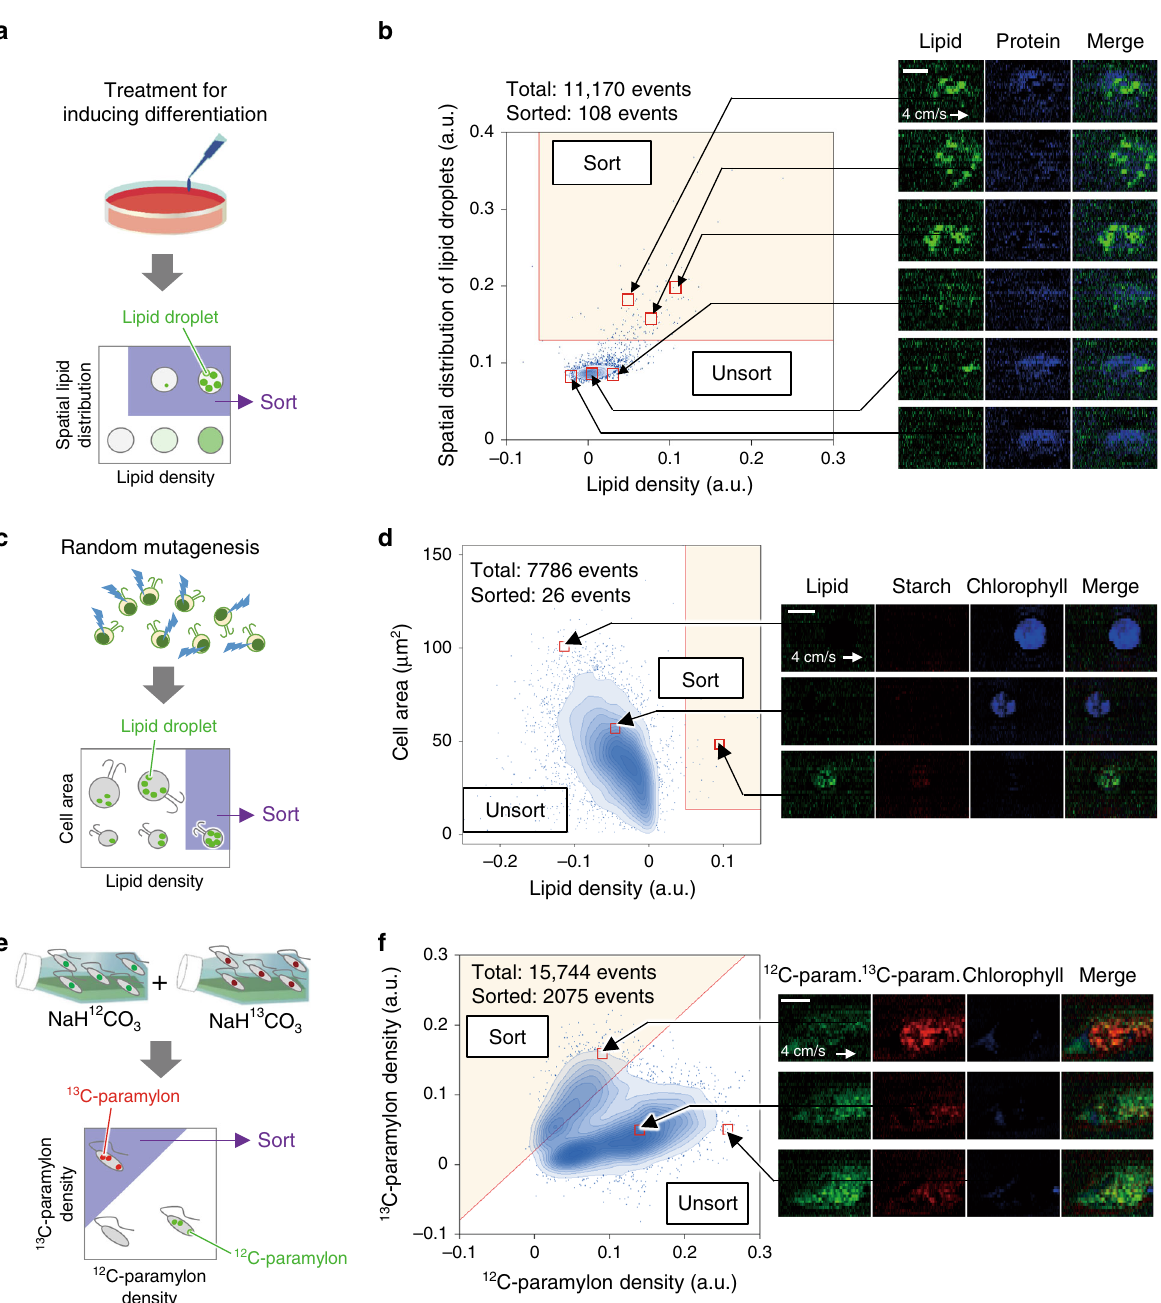
Fig. 4 Raman image-activated sorting of various types of cells with the RIACS. a Procedure for sorting adipocyte-like cells. b Scatter plot of differentiated and undifferentiated 3T3-L1 cells in the spatial distribution of intracellular lipid droplets and the lipid intensity per cell area. 3T3-L1-derived adipocyte-like cells with a large spatial distribution of cytoplasmic lipid droplets (indicated by the yellow region) were sorted by the RIACS. The insets show representative SRS images of cells in the sort ( n = 108) and unsort regions ( n = 11,068). Scale bar: 10 µ m. c Procedure for sorting Chlamydomonas sp. cells. d Scatter plot of Chlamydomonas sp. mutant cells in cell area and lipid density. Highly lipid-rich, but rare (only 0.3% of the total population) Chlamydomonas sp. mutants (indicated by the yellow region) were sorted by the RIACS. The inset shows representative SRS images of cells in the sort ( n = 26) and unsort regions ( n = 7760). Scale bar: 10 µ m. e Procedure for sorting Euglena gracilis cells. f Scatter plot of the 50/50 mixture of Euglena gracilis cells cultured in NaH 12 CO 3 and NaH 13 CO 3 in 12 C- and 13 C-paramylon intensity per cell area. Euglena gracilis cells cultured in NaH 13 CO 3 (indicated by the yellow region) were sorted by the RIACS. The inset shows representative SRS images of cells in the sort ( n = 2075) and unsort regions ( n = 13,669). Scale bar: 10 µ